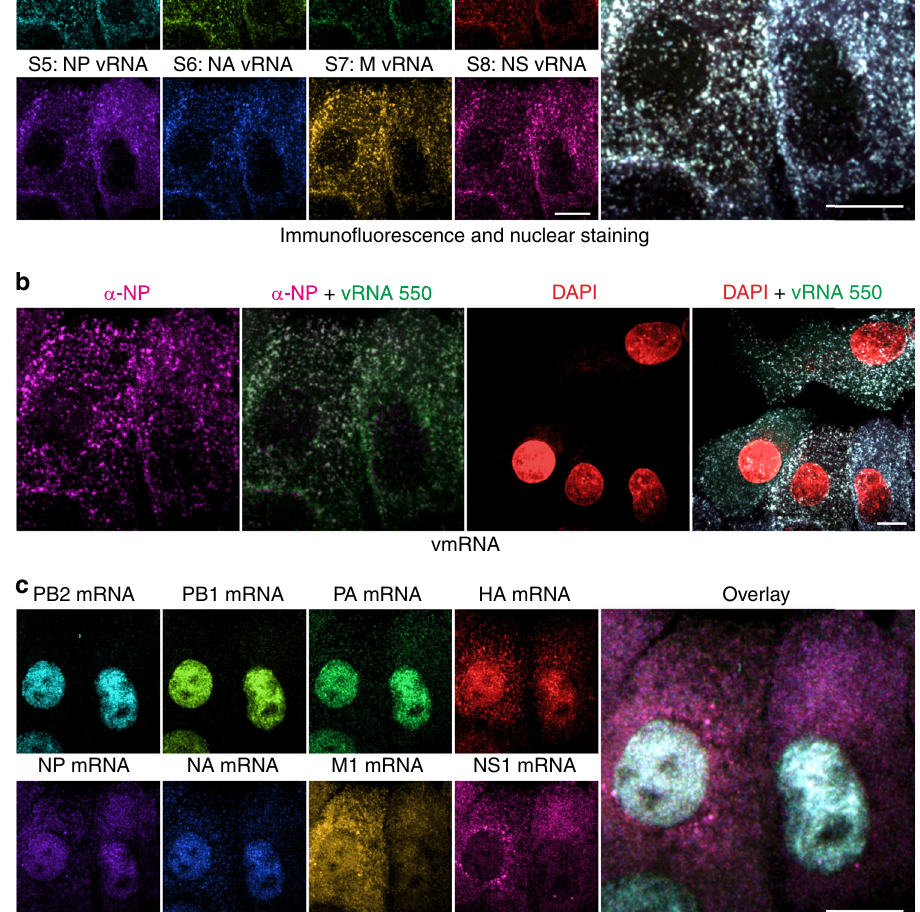
Fig. 1 Localisation of viral RNA (vRNA) and vmRNA in A/Panama-infected A549 cells. a Viral genomic RNAs were stained by fl uorescence in situ hybridisation (FISH) 10 h.p.i. (MOI 5). To cover all vRNAs and major vmRNAs, 12 cycles of FISH labelling were performed. Along these cycles, each vRNA was targeted twice, once with Atto550 (shown here) and once with STAR635- (Supplementary Fig. 1b) labelled probe sets (for details see text). b Immuno fl uorescence staining of NP. DAPI (4 ′ ,6-Diamidin-2-phenylindol) labelling was performed to exclude nuclear vRNA spots for further colocalisation analysis. c All major unspliced vmRNAs were stained. Images represent max z projections. The intensities of images were scaled according to the corresponding images taken after probe removal by formamide. Scale bars correspond to 10 µ m. Representative images of four independent experiments are